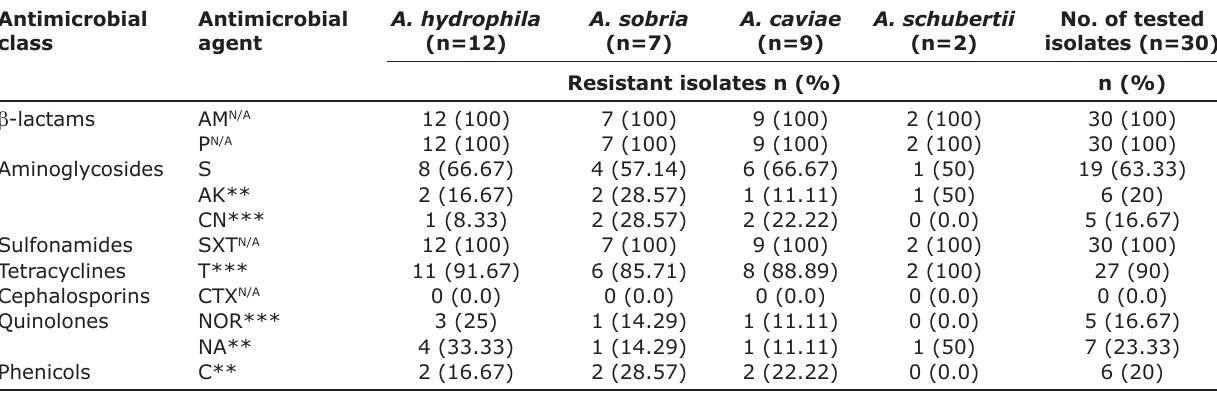
Table-3: Antimicrobial resistance profile of Aeromonas spp. isolates. Antimicrobial Antimicrobial class